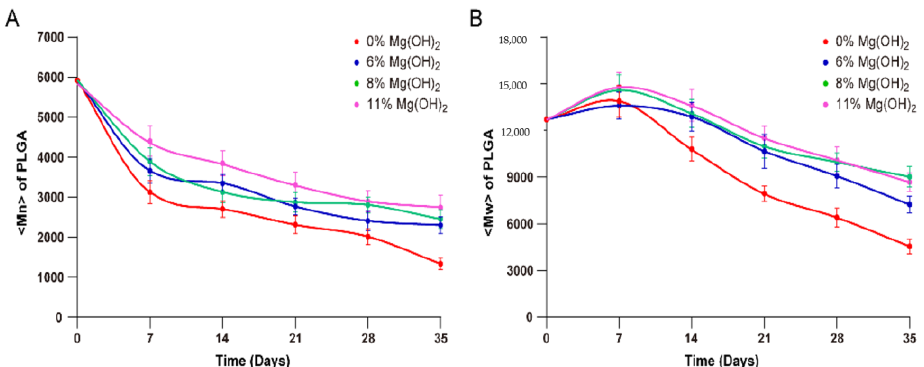
Figure 6. Mn (A) and Mw (B) of PLGA in microspheres under incubation of different times analyzed by GPC (means ± SD, n = 3). 1: MS 0% Mg(OH) 2 , 2: MS 6% Mg(OH) 2 , 3: MS 8% Mg(OH) 2 , 4: MS 11% Mg(OH) 2 (1 vs. 2–4, p <